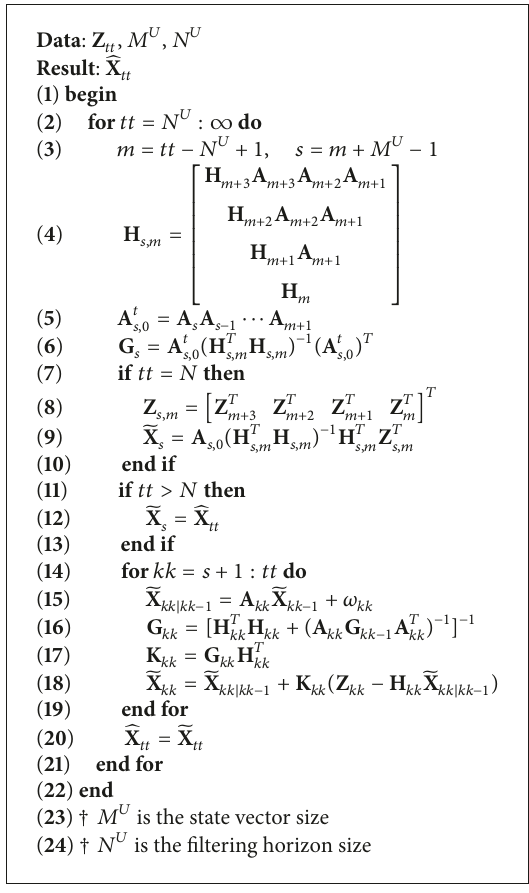
Algorithm 2: UFIR filter algorithm for the self-contained